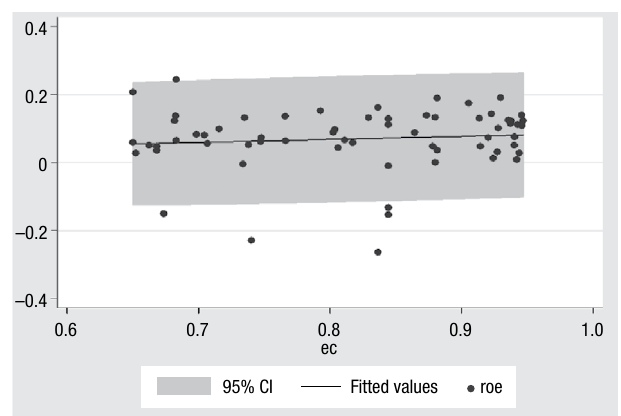
Fig. 1. ROA and Cost Efficiency